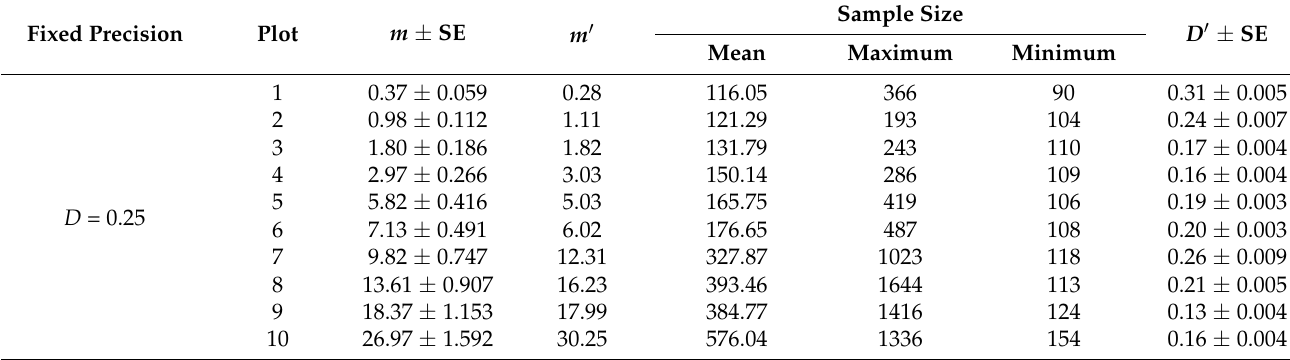
Table 2. Statistical results for 1000 bootstrap resampling repetitions. Binomial sampling with fixed precision D = 0.25. Fixed